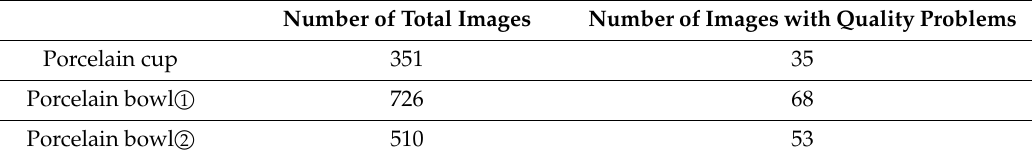
Table 4. Porcelain artifacts dataset.